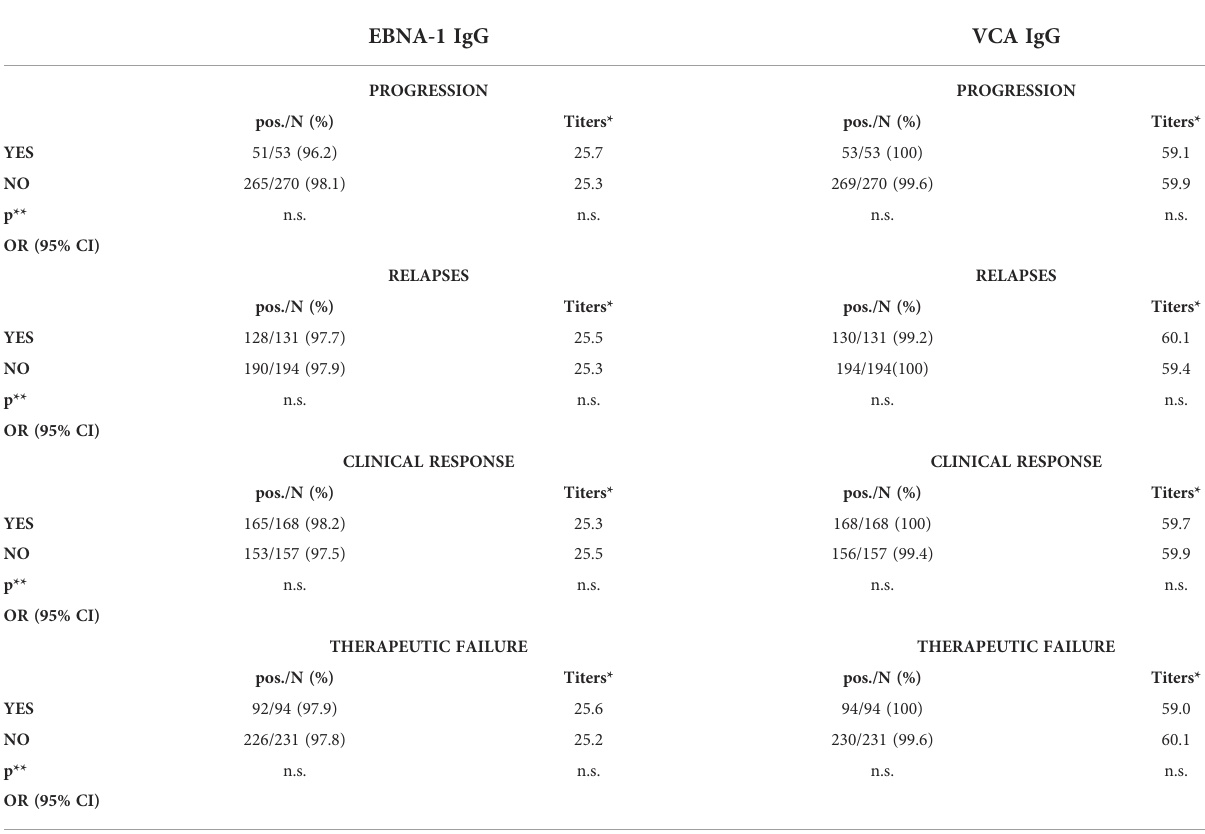
TABLE 4 EBNA-1 and VCA IgG titers at baseline visit (prior DMT onset) and progression, number of relapses, clinical response and therapeutic failure after two years of follow-up with